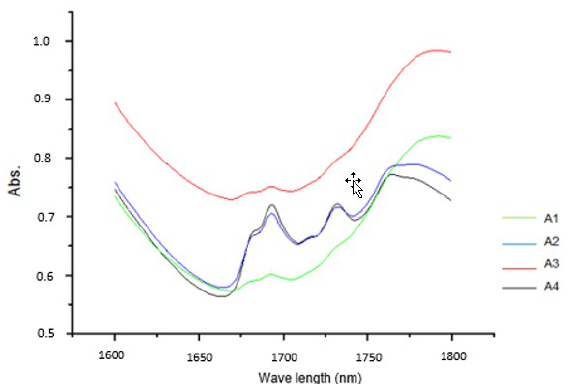
Figure 2. Chart showing absorption spectra of the solutions A, B, C, and D to the solutions distilled to 10% by volume.